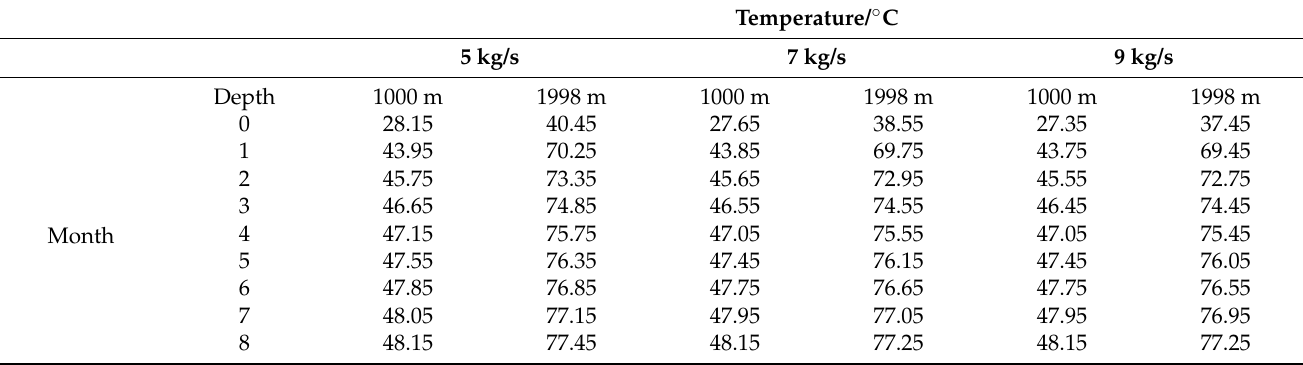
Table 5. Temperature recovery effects of 5, 7 and 9 kg/s.